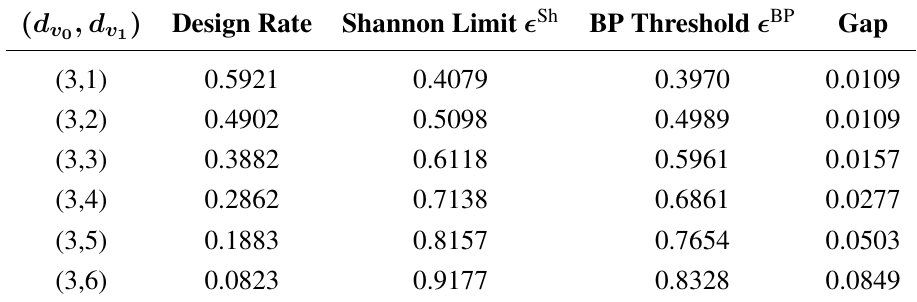
over binary erasure channels { 0 , 1 }